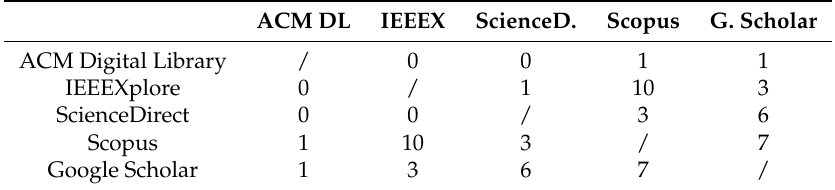
Table 2. Databases‘ matrix with duplicates shown between each database:database